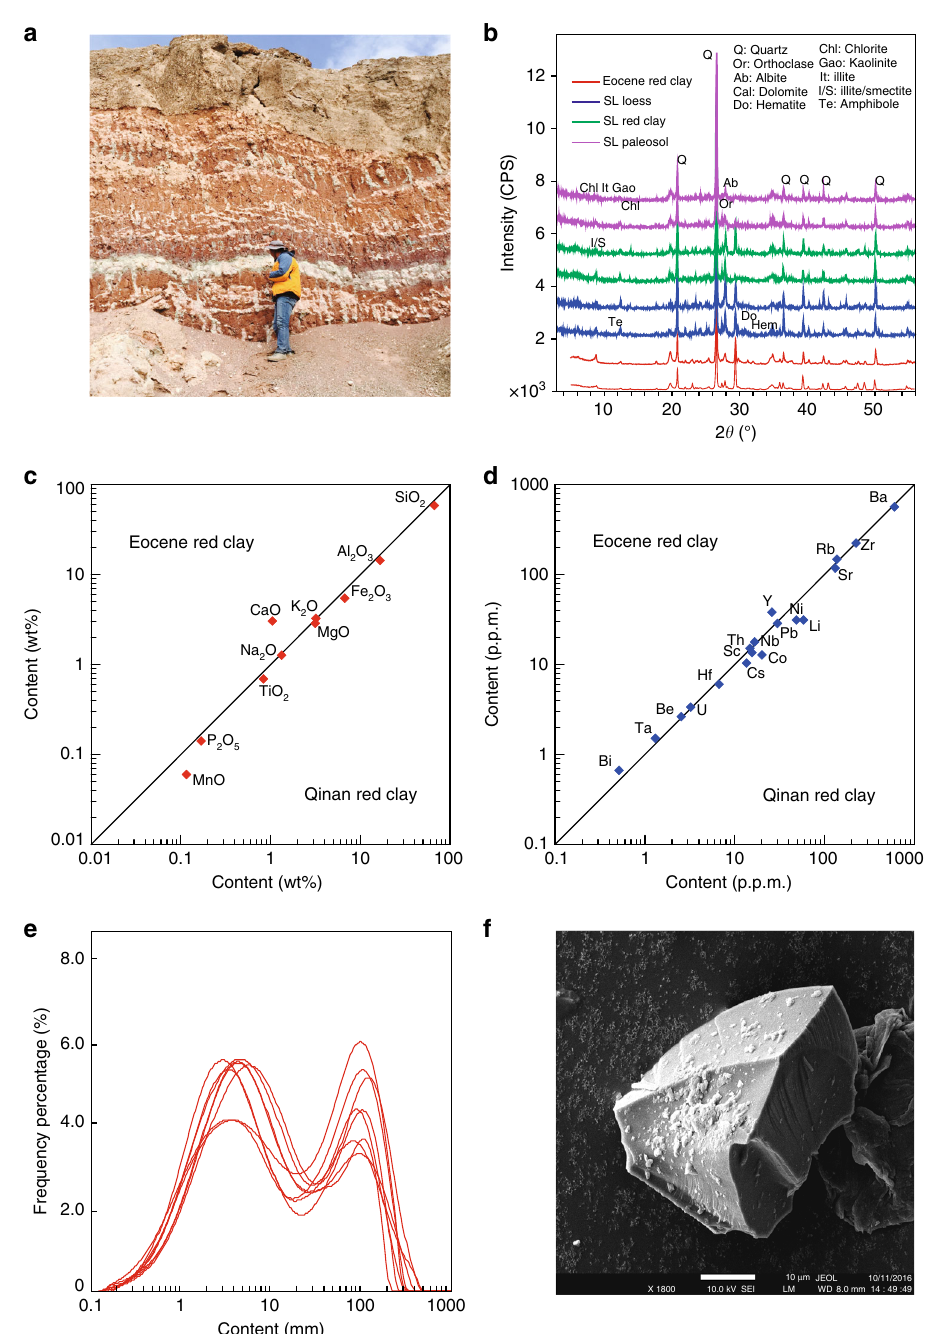
Fig. 2 Evidence for an aeolian origin of the studied red clay. a Field photograph of alternating reddish-brown clay and grey caliche nodule layers. b Mineral composition from X-ray diffraction results from bulk sediments for the studied red clay in Altun Shan, compared with Quaternary loess and red clay from Shilou 61 (SL) on the Chinese Loess Plateau. c , d Average major and trace element distributions for the studied red clay from Altun Shan compared with red clay from Qin ’ an 62 . e Grain size distributions for the studied red clay from Altun Shan. f Scanning electron microscope image of representative quartz grains that illustrate the angular morphology of the